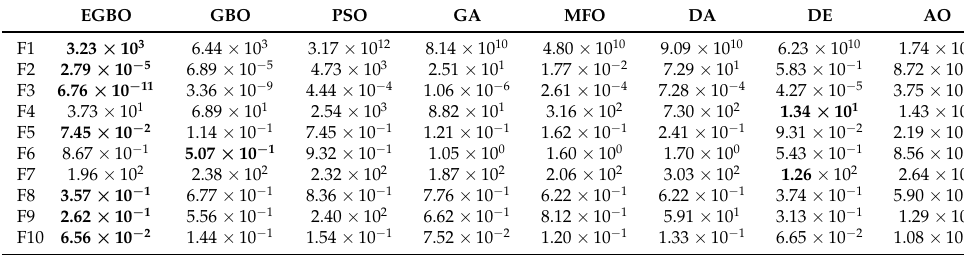
Figure 1. Average fitness function values for all methods in all functions. Table 2. Results of the Std measure of the fitness function values.